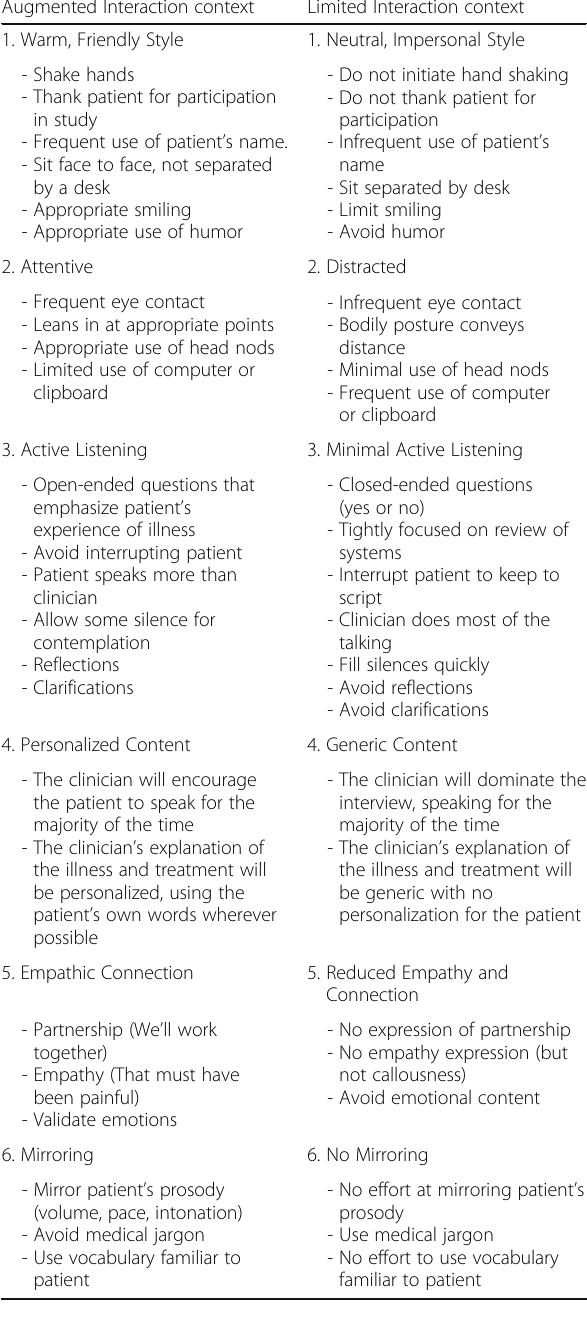
Table 1 Guideline for augmented and limited interaction context Augmented Interaction